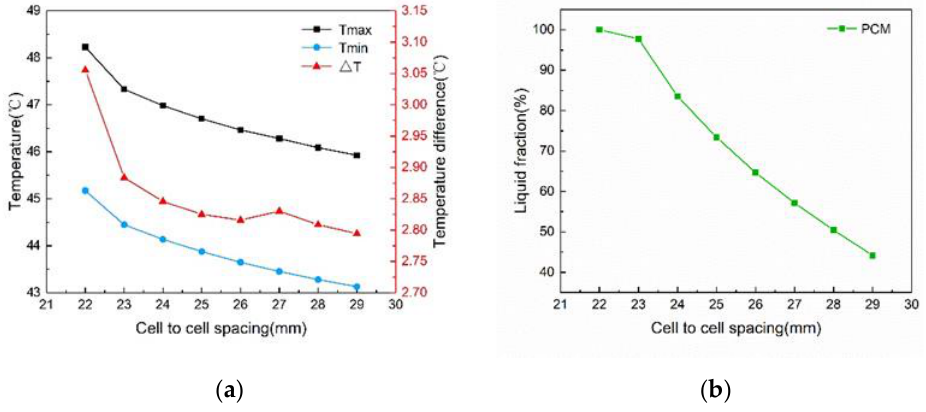
Figure 5. ( a ) T max , T min , and ∆ T at 1800 s for different cell spacings. ( b ) PCM liquid fraction at 1800 s for different cell spacings.